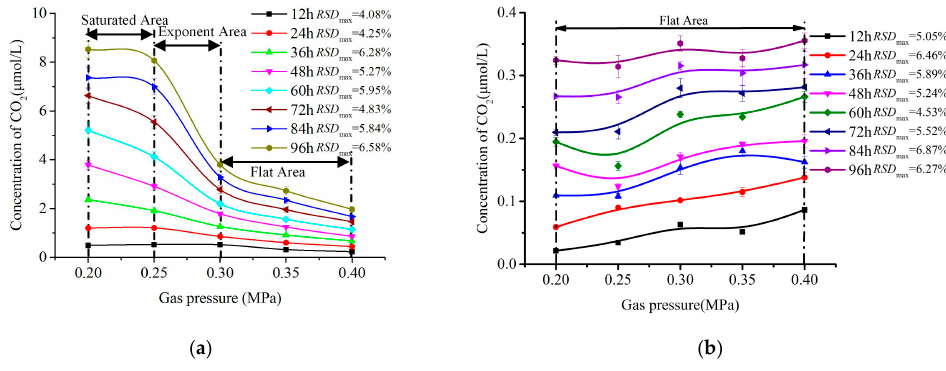
Figure 6. Correlation between CO 2 concentration and pressure: ( a ) Protrusion and ( b ) particles.